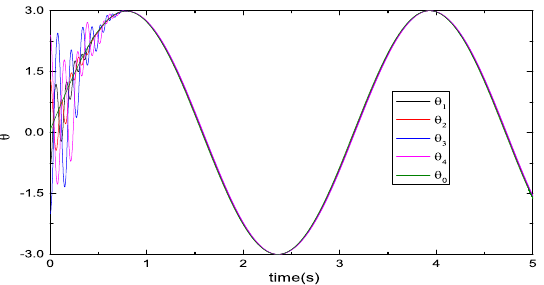
Figure 12. Consensus dynamic tracking curve of all motors under the reference signal θ 0 = 3sin ( 2 t ) : position signals of all motors.